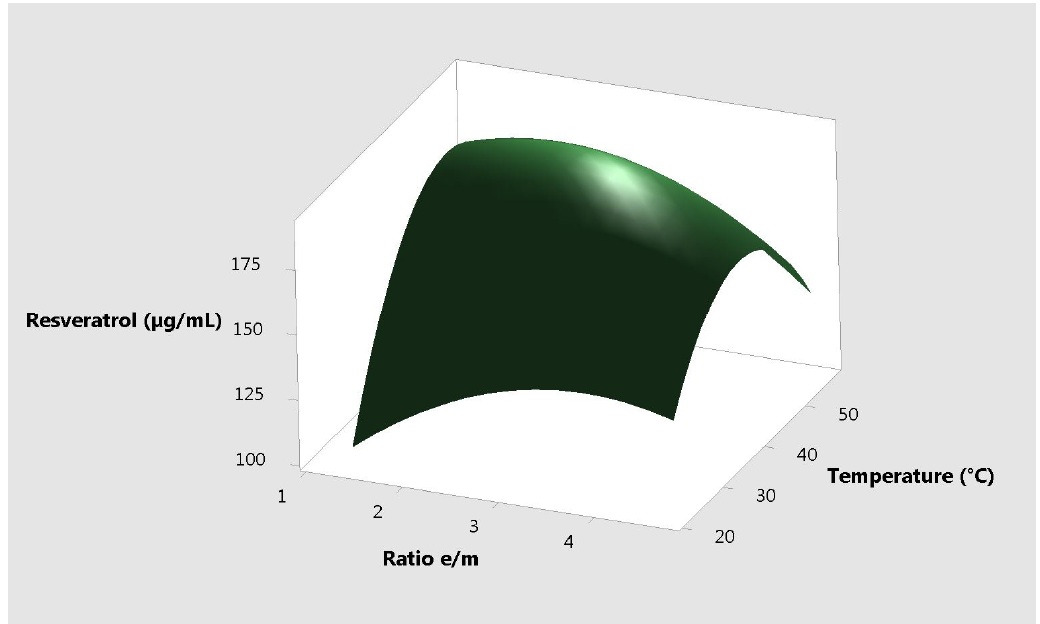
Figure 3. Surface plot resveratrol vs. temperature and ratio e / m.